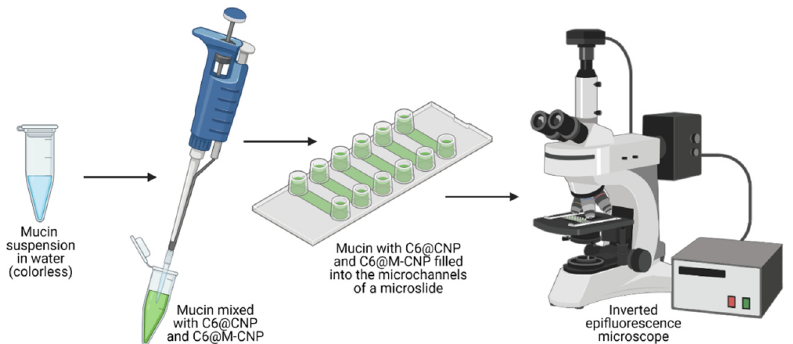
Figure 2. The protocol of mucoadhesion studies. Purified porcine gut mucin was dispersed in wa- ter (1 mg/mL), aliquoted to an Eppendorf tube, and mixed with C6@CNC or C6@M-CNC suspen- sion (150 µg/mL). The mixture was then injected into the microchannels of an optically translucent microslide with six parallel microchannels before being imaged in an inverted microscope ( λ ex/em = 470/525 nm).